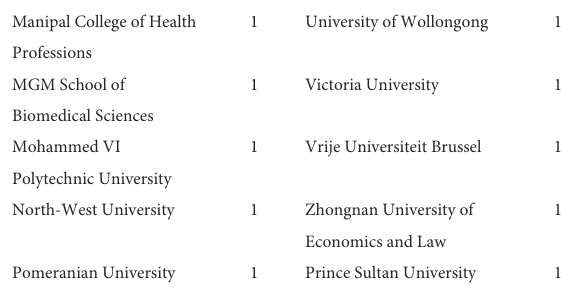
TABLE 12 Affiliated universities/institutions of the